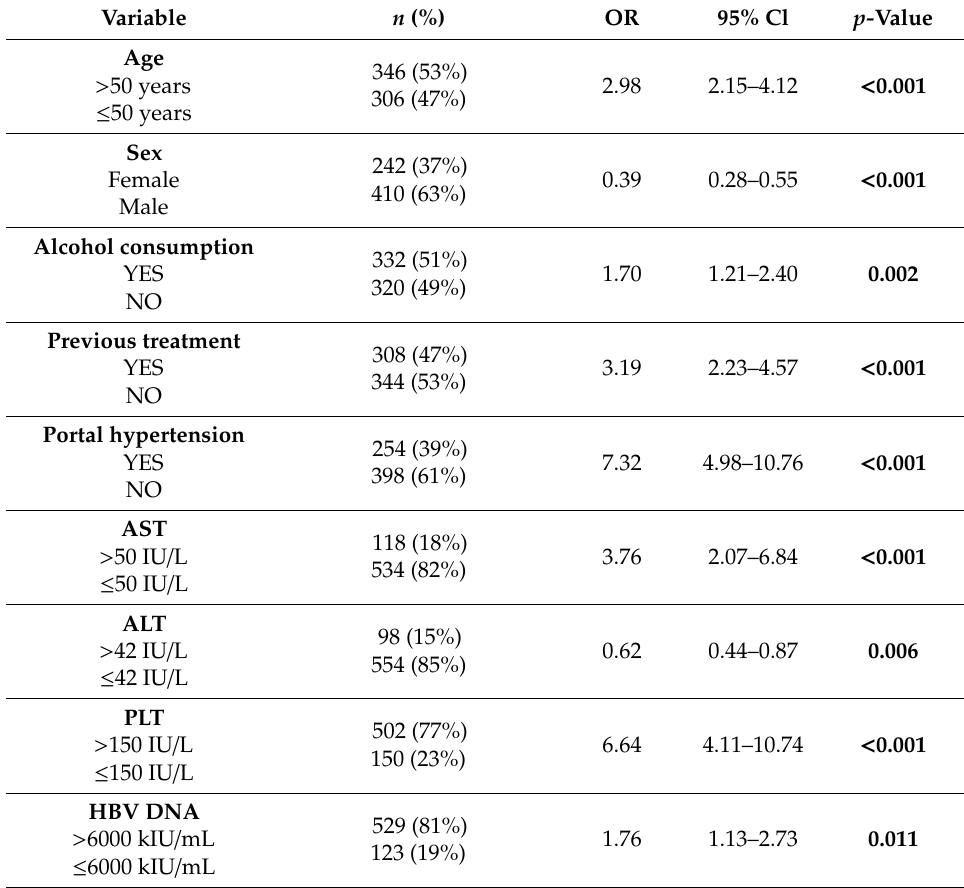
Table 4. Results of univariate analyses for the risk of advanced liver fibrosis † in chronic hepatitis B